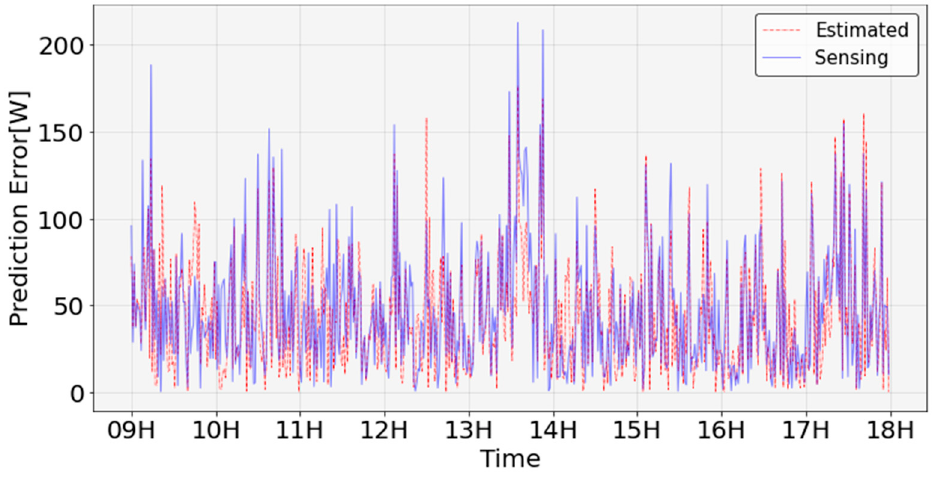
Figure 17. Energy consumption prediction error based on sensing and prediction data.